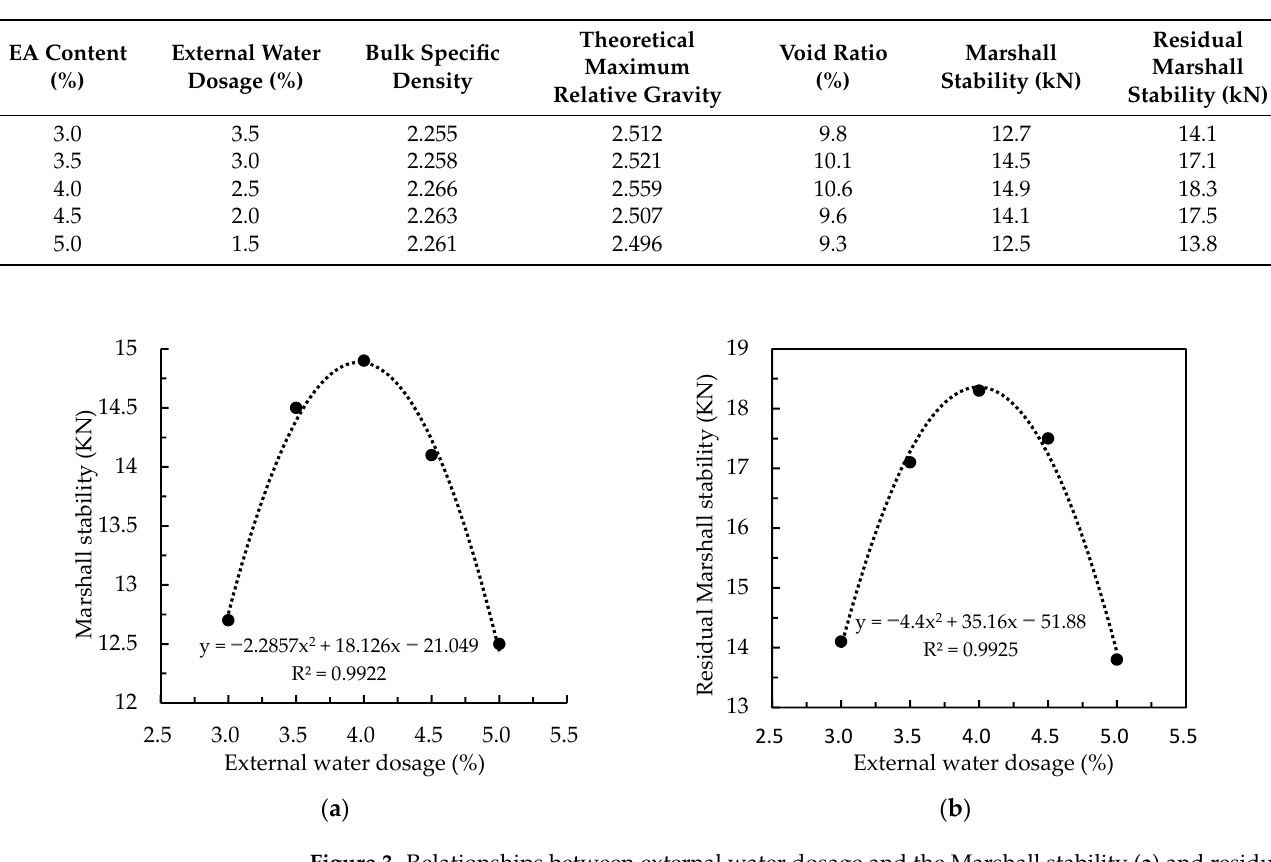
Table 7. Volume Index and Marshall Stability of Specimens.